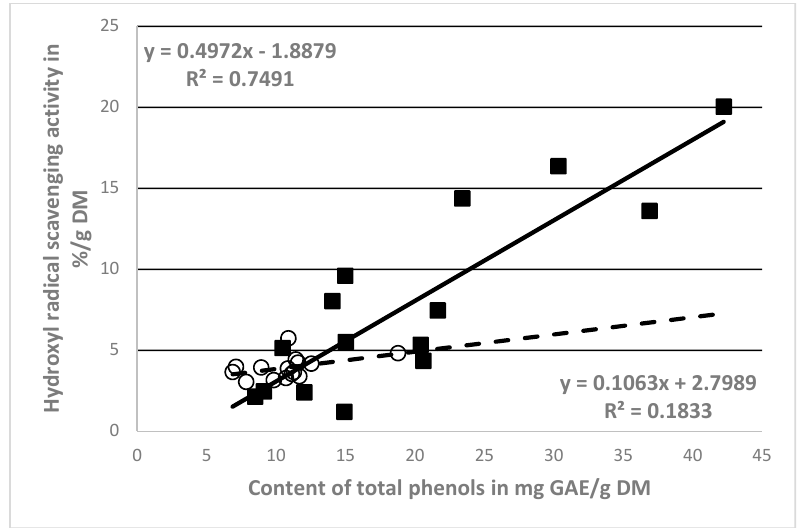
) extracts. (cid:35)